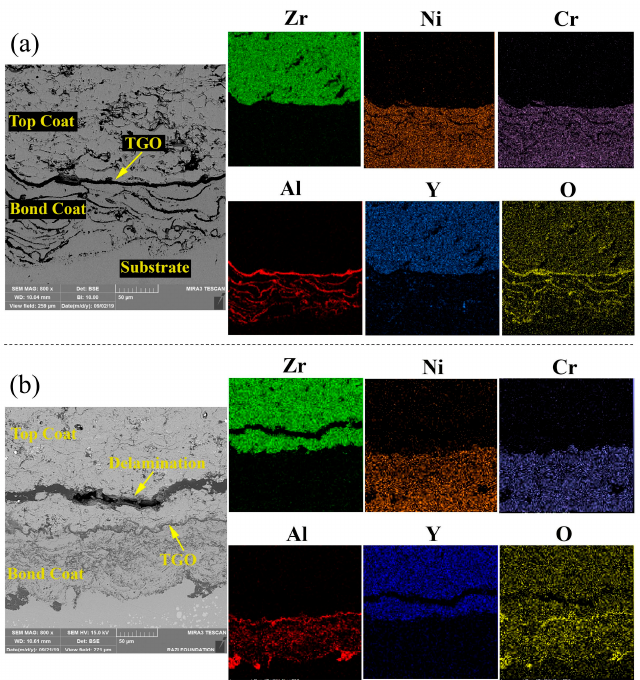
Figure 7. SEM image and EDS analysis map of the polished cross-section of the TBC with the topcoat of ( a ) 280 µ m ( b ) 1000 µ m after 150 h of oxidation test at 1000 ◦ C